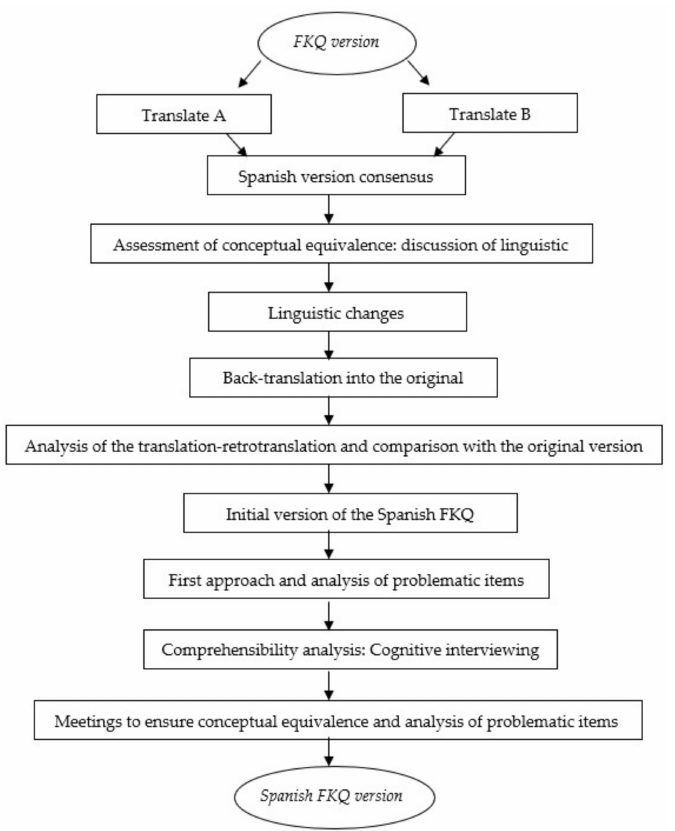
Figure 1. Procedure for translation and cultural adaptation of the Spanish version of the question- naires belonging to the Canadian Physical Literacy